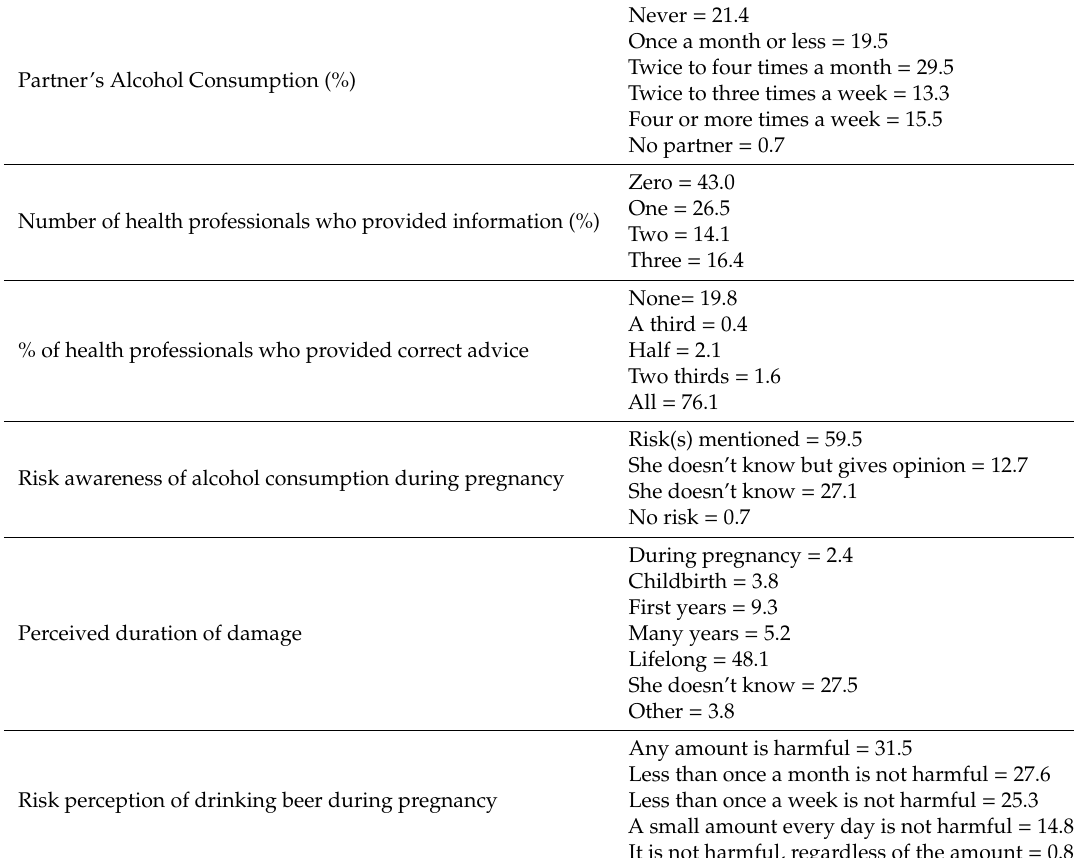
Table 1. Descriptive statistics of study